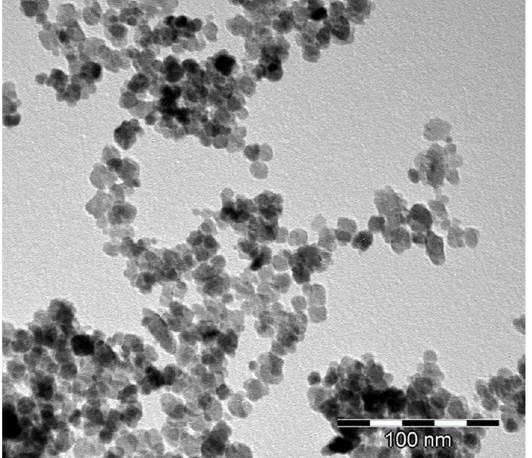
Figure 2. Transmission electron micrographs of the MgO–ZrO 2 powder of 7.4 mol%.